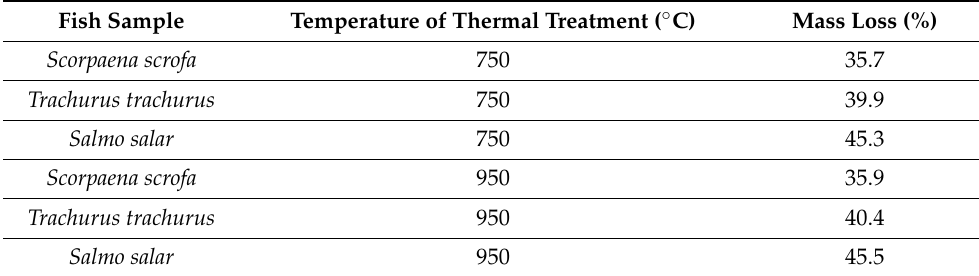
Table 2. Mass loss of fish bones at 750 and 950 ◦